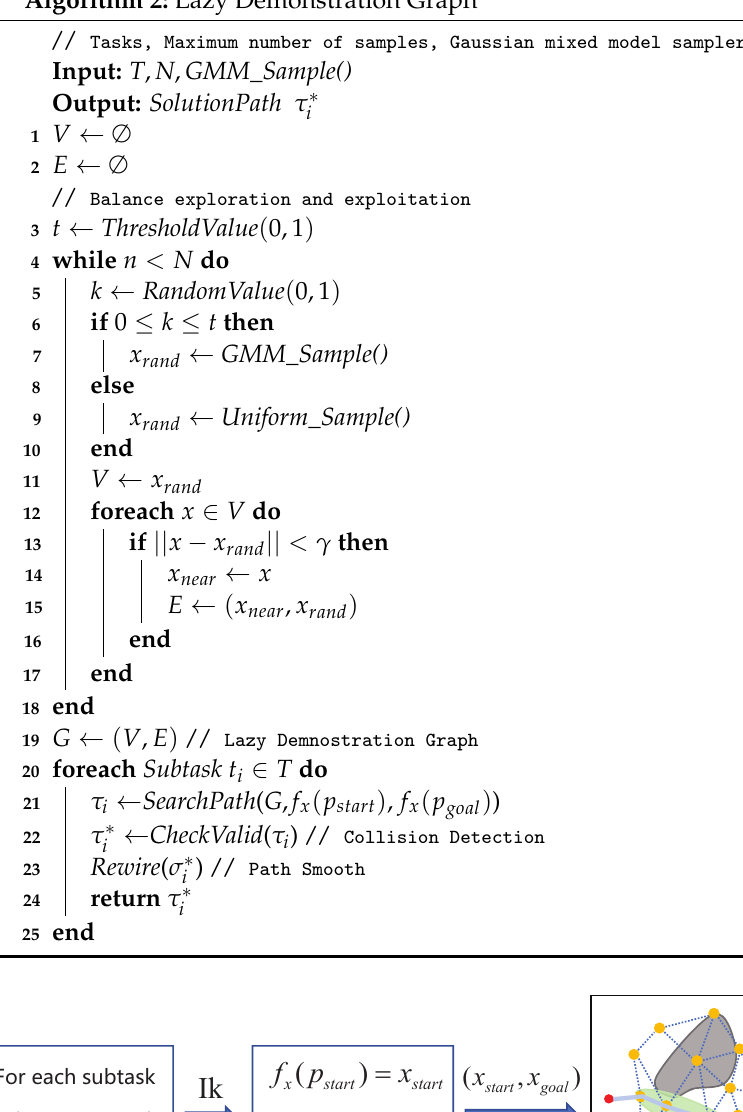
Algorithm 2: Lazy Demonstration Graph